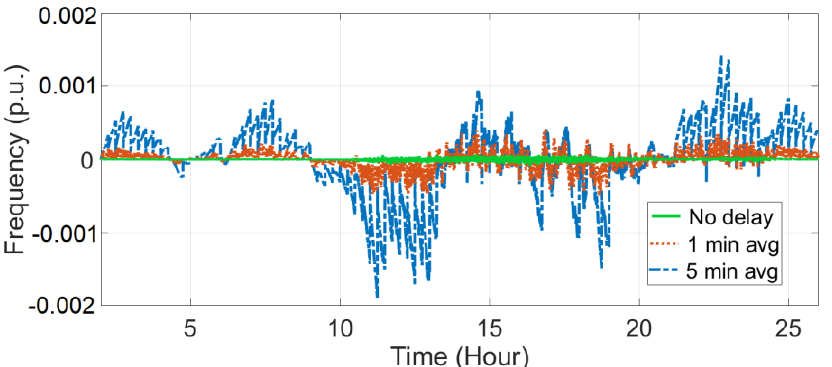
Figure 24. Comparison of the different demand averaging intervals on frequency deviation.